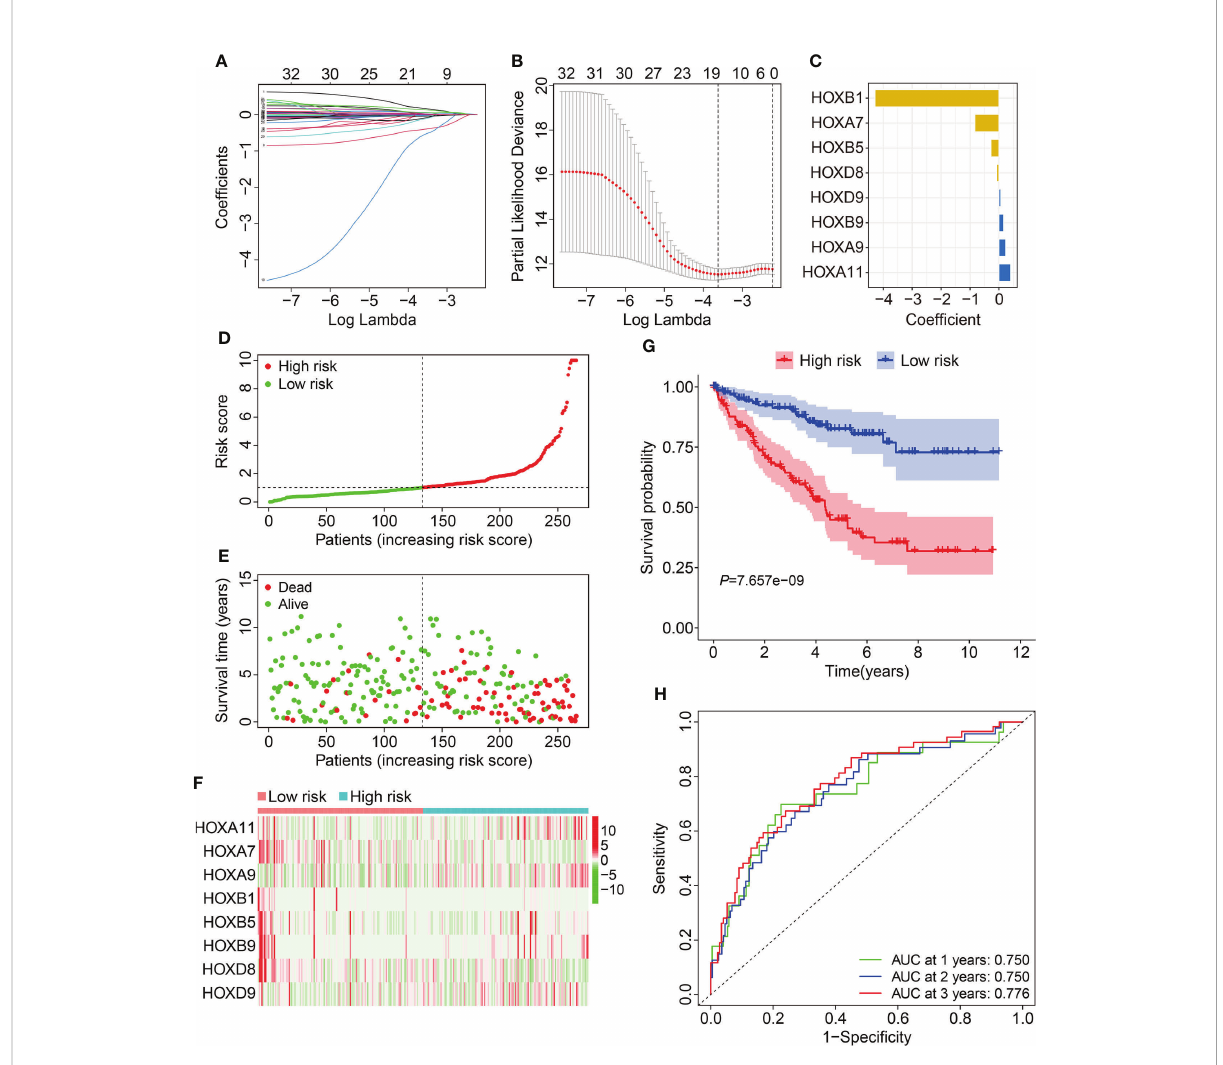
FIGURE 2 Construction of HOX family gene-based signature in ccRCC. (A, B) LASSO regression analysis and multivariate Cox analysis. (C) The distribution of the coef fi cient of the eight HOX family genes. (D, E) The distribution of risk score and survival status in high- and low-risk groups. (F) The